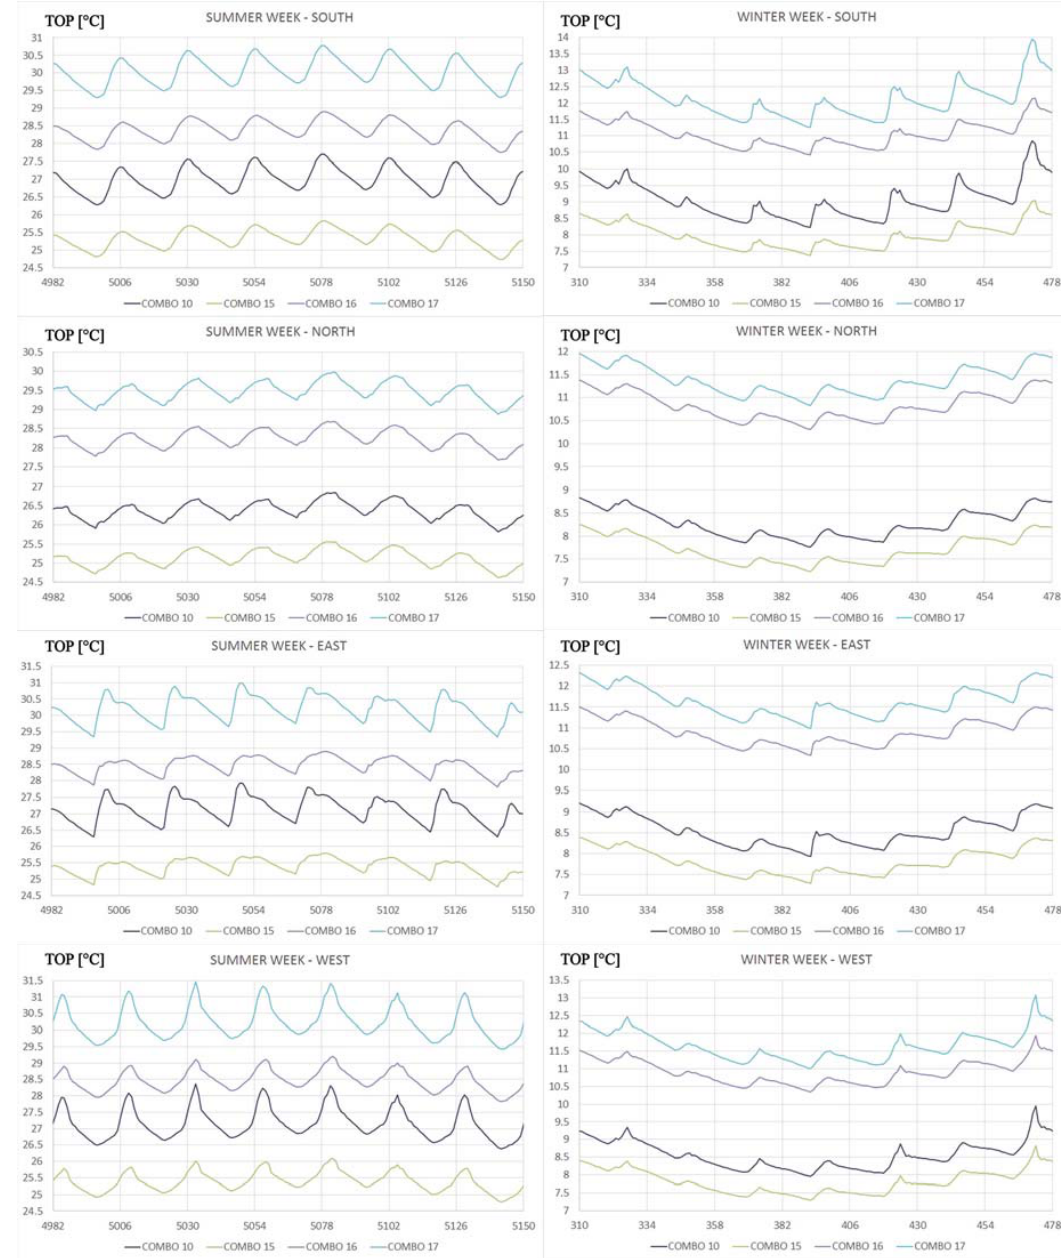
Figure 9. TOP graphical trend for the STEP 7 and STEP 8 (27 July–2 August; 12 January–18 January).